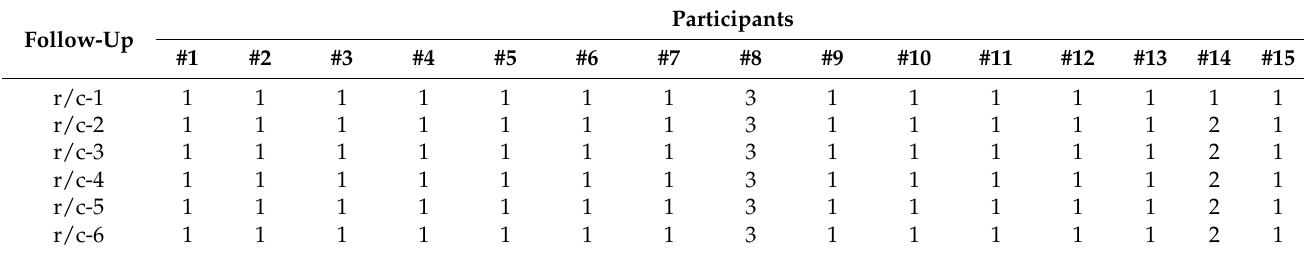
Table 5. Scores according to the FDI criteria for functional properties during 6-month follow-up evaluation. Follow-Up